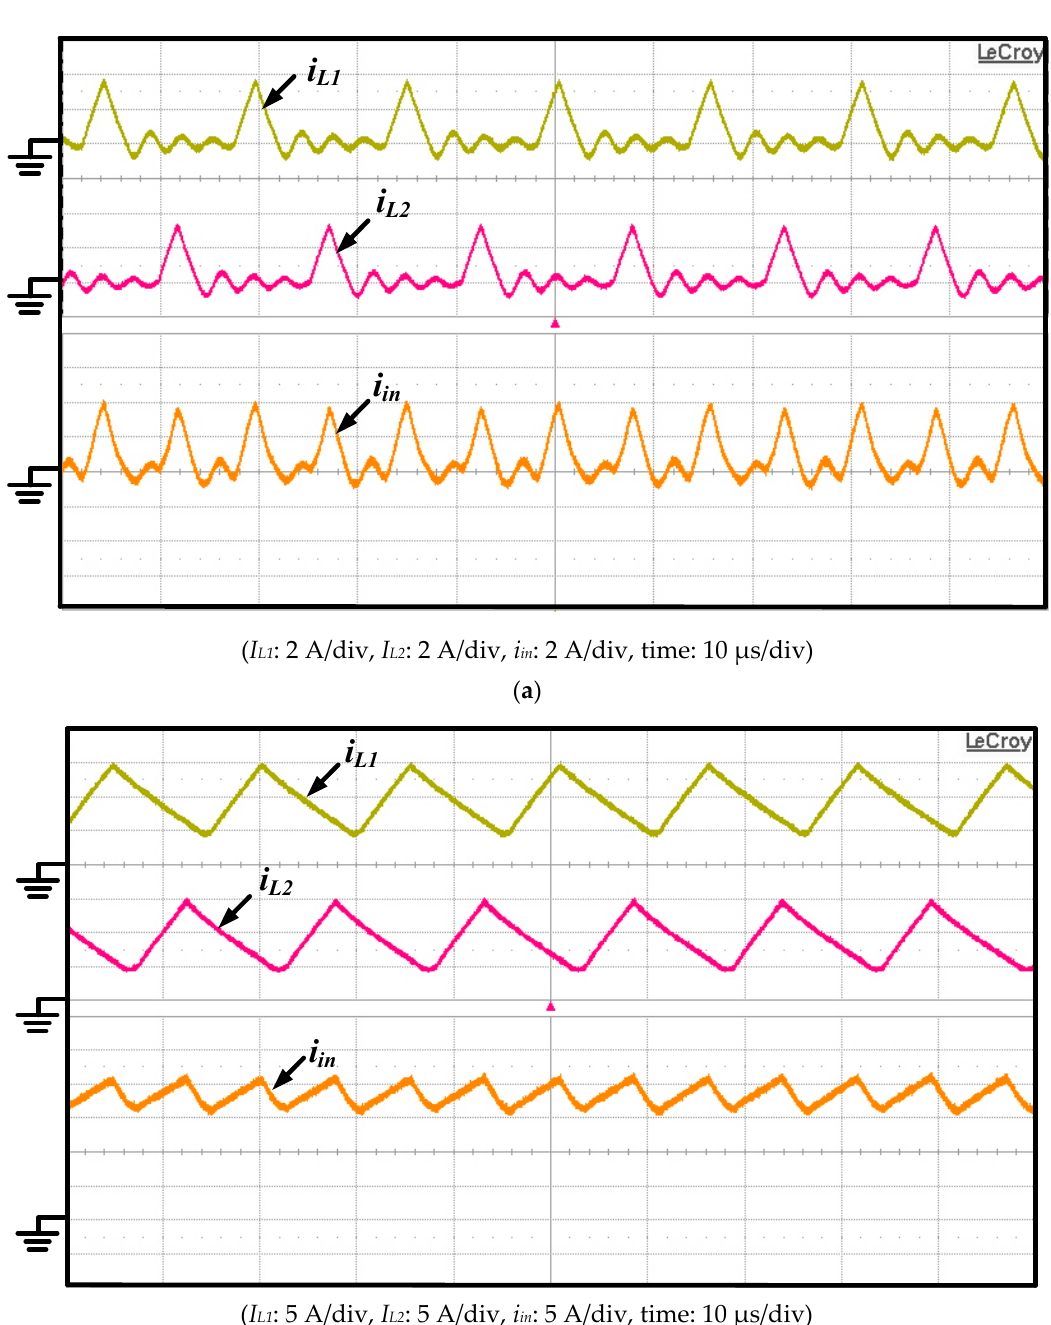
Figure 10. Measured currents i L1 and i L2 and i in waveforms of the proposed interleaving boost converter with ( a ) 10% of full-load condition, and ( b ) 100% of full-load condition under AC 90V of input voltage.